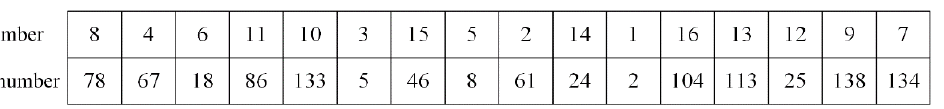
Figure 5. Coding diagram. Figure 5. Coding